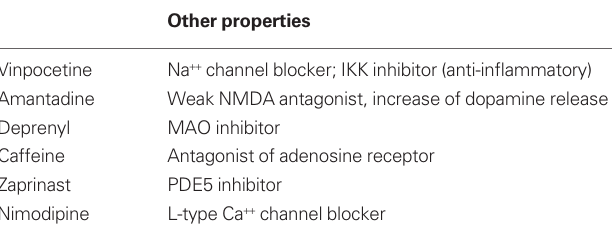
Table 1 | Non-specific properties of some PDe1